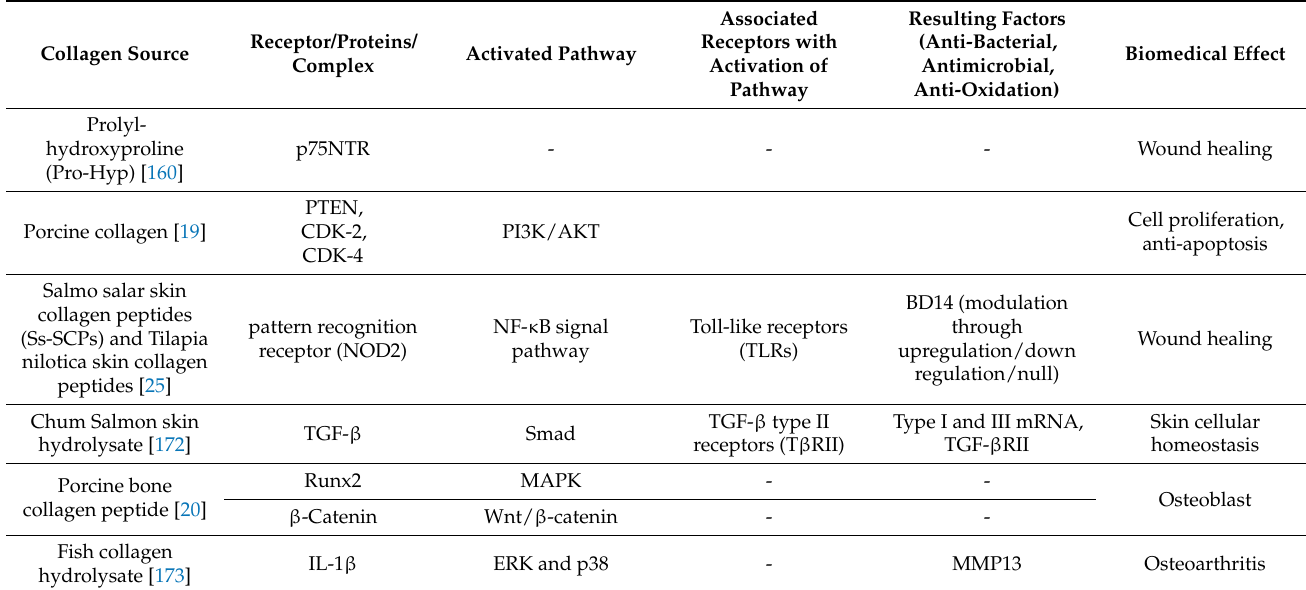
Table 8. Literature with respect to receptors and